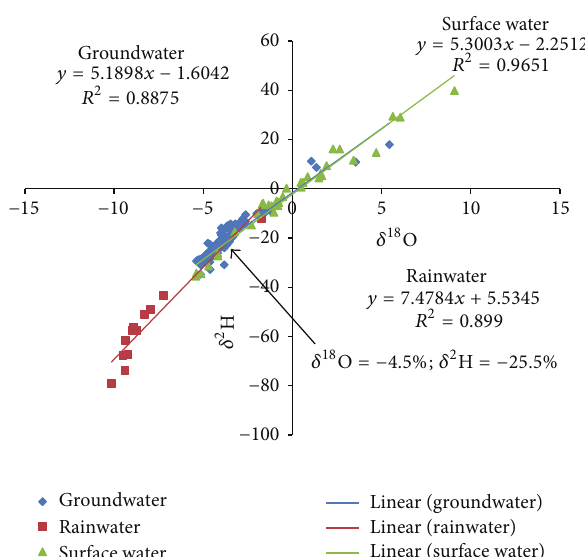
Figure 3: Stable isotope signatures of rainwater, surface water, and groundwater from parts of the White Volta Basin,